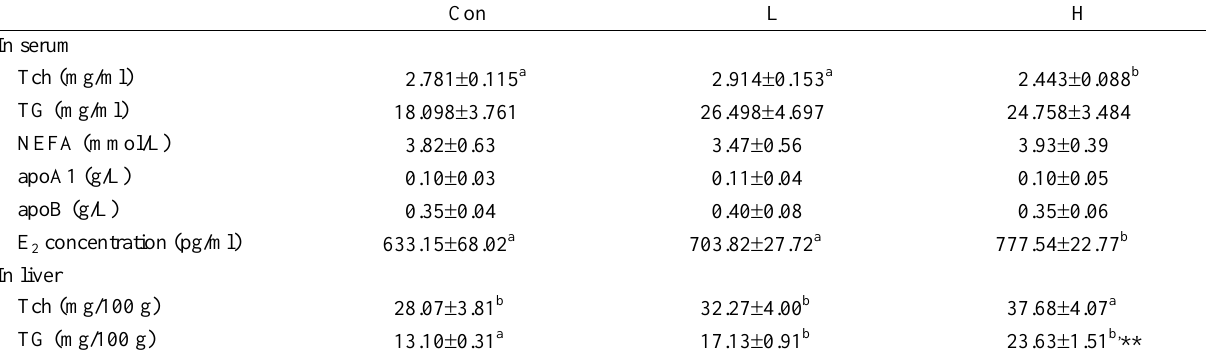
Table 2. Effects of kp-10 on the contents of parameters in serum and